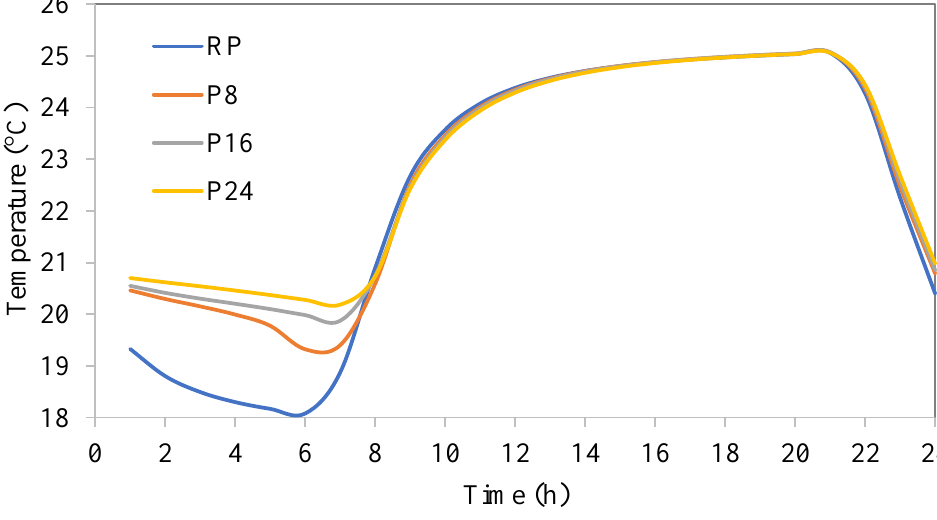
Figure 10. Distribution of interior surface temperatures of studied plasters applied during winter in Prague.